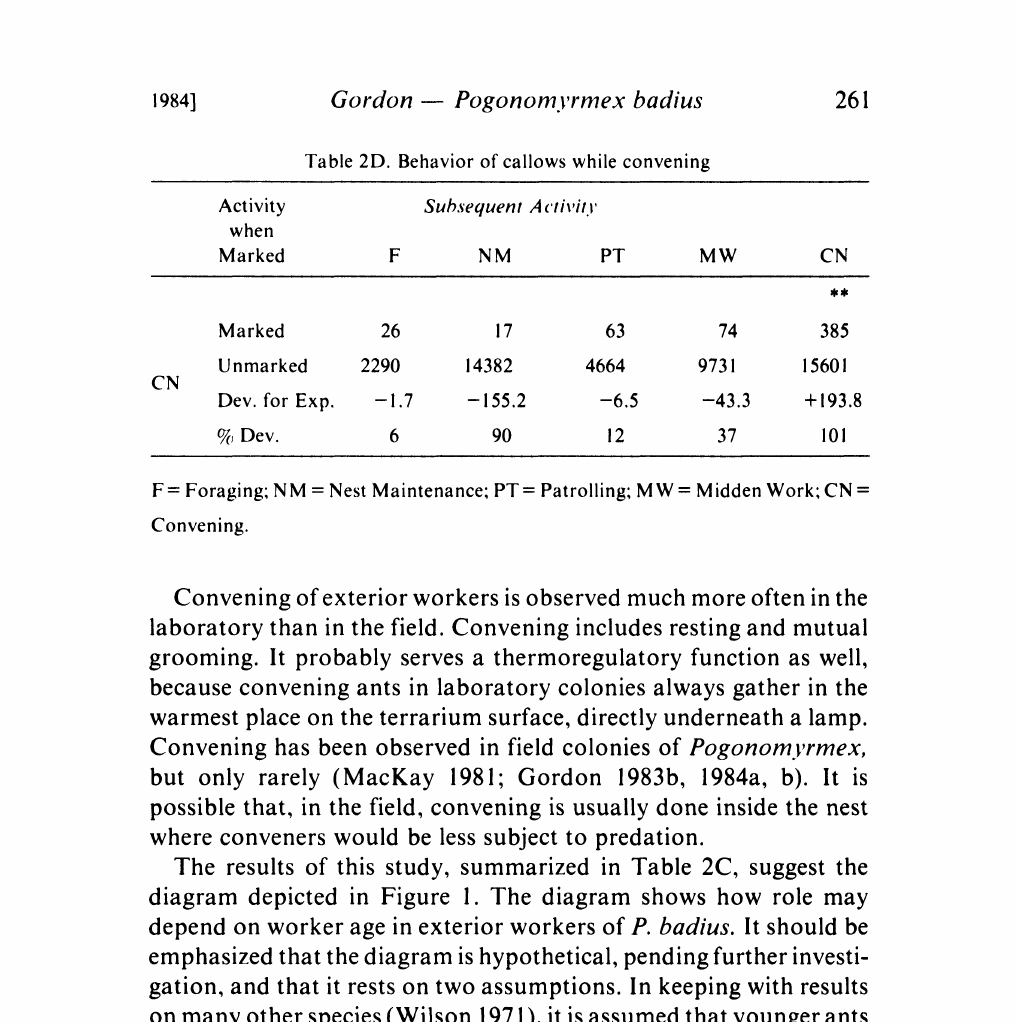
Table 2D. Behavior of callows while convening